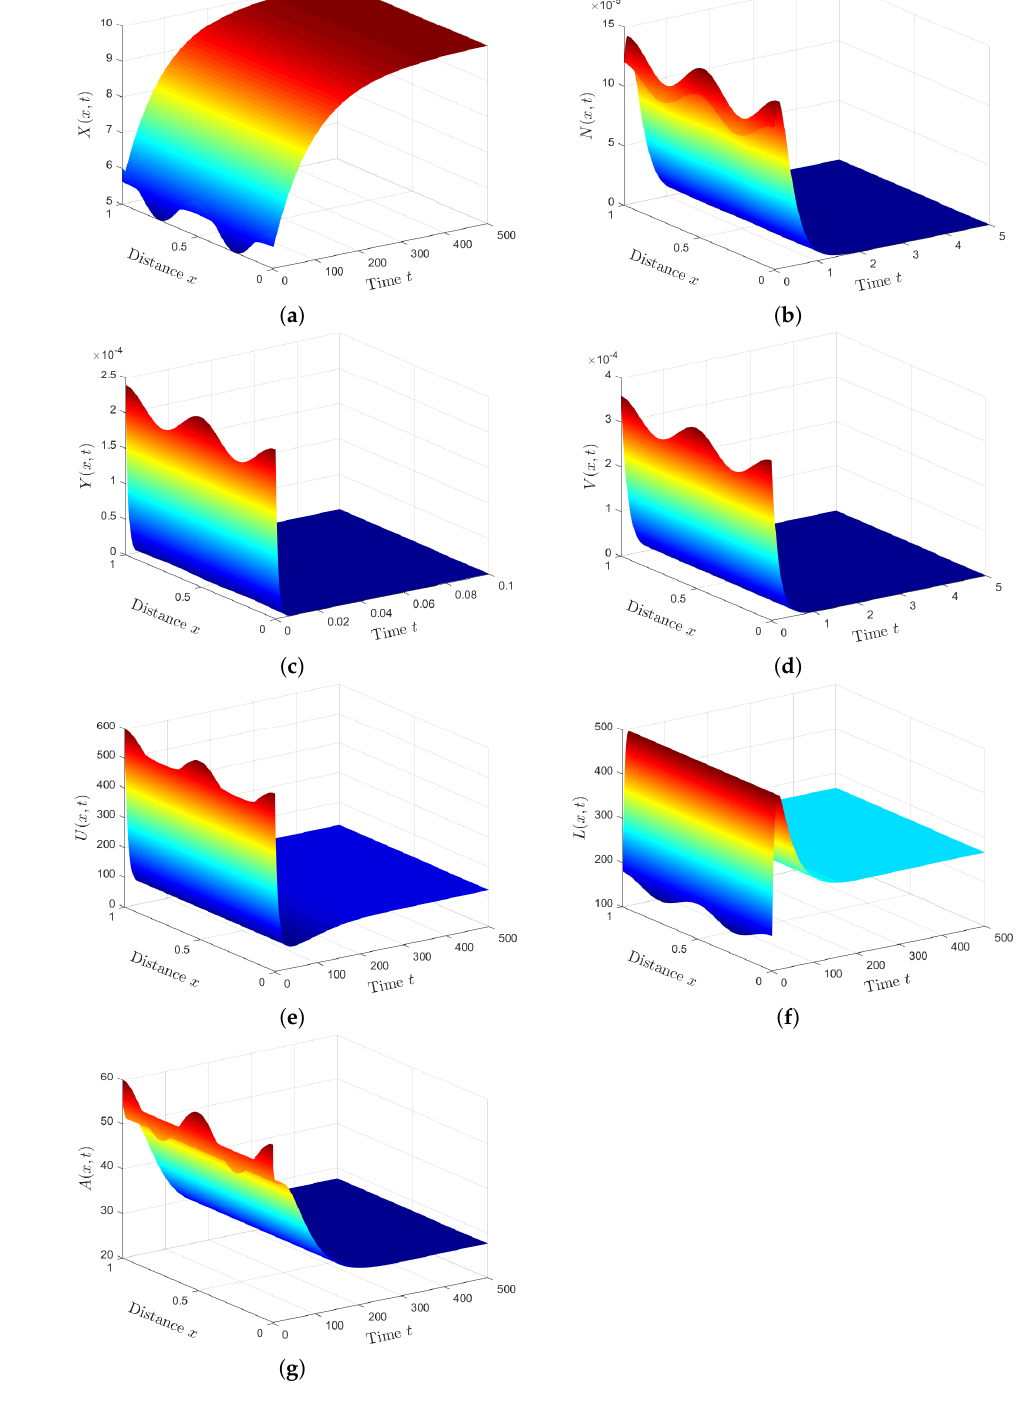
Figure 2. Numerical solution of PDEs (12)–(18) with initial condition (47) and boundary condition (48) in Plan (II). ( a ) Healthy ECs. ( b ) Latent infected ECs. ( c ) Active infected ECs. ( d ) SARS-CoV-2. ( e ) Healthy T cells. ( f ) Latent infected T cells. ( g ) Active infected T